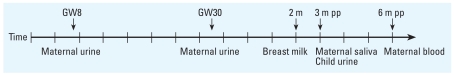
Sampling points, maternal urine GW8 and GW30, breast milk 2 months (m) postpartum (pp), maternal saliva and child urine at 3 m pp, and maternal blood 6 m pp.